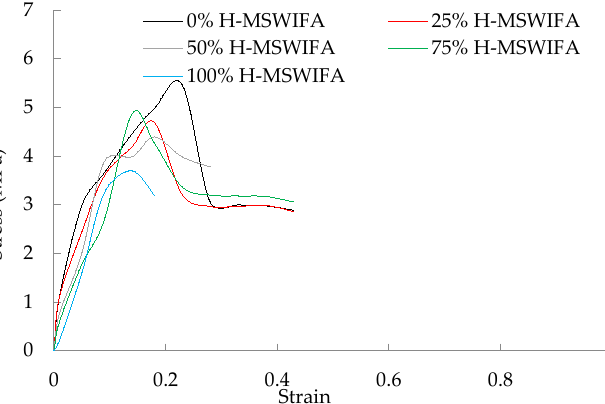
Figure 11. FSFE curve of asphalt mastic at F/A of 1.4.